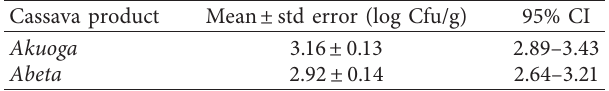
Table 1: Yeast and mould counts in Abeta and Akuoga cassava products.